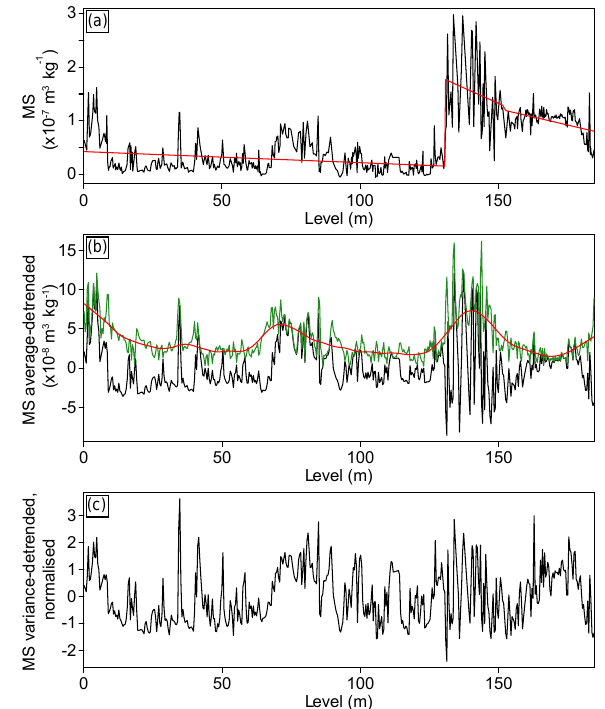
Figure 7. Detrending procedure of the magnetic susceptibility (MS) series from the La Thure section. (a) Raw MS signal (black curve) with piecewise best-fit linear trend of the average (red curve). (b) MS series after subtraction of the piecewise linear trend (black curve), with instantaneous amplitude (green curve) and LOWESS regression of the instantaneous amplitude applied with a coeffi- cient of 10% (red curve). (c) MS curve after dividing the MS se- ries “average-detrended” by the LOWESS regression of the instan- taneous amplitude and after